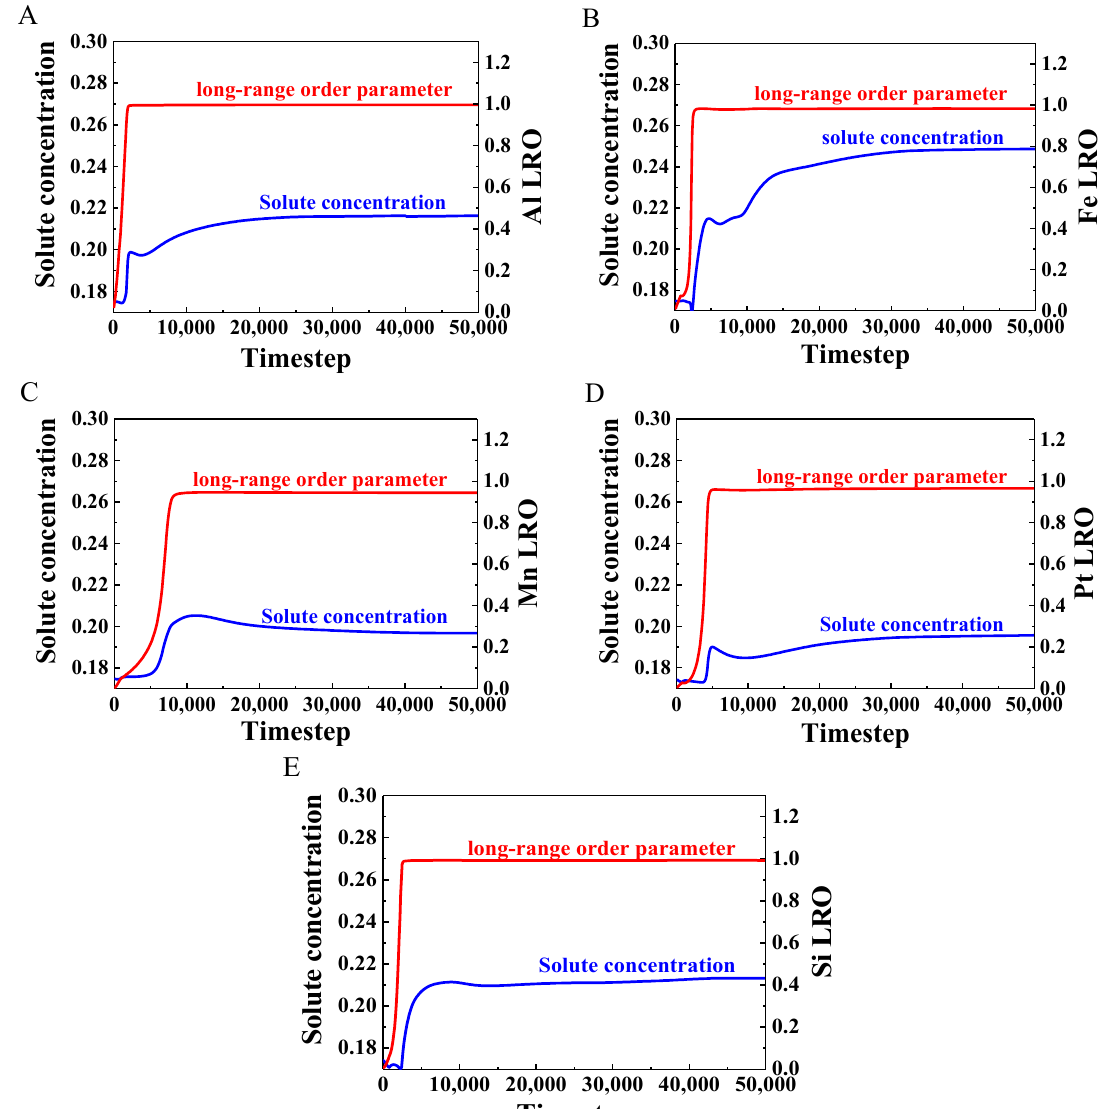
Figure 7. The temporal evolution of long-range-order parameter and solute concentration for: ( A